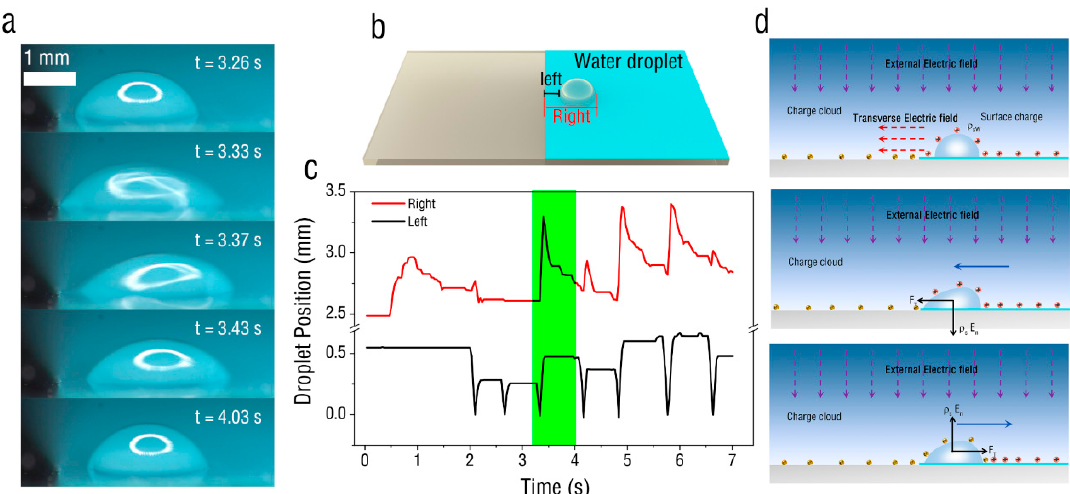
Figure 2. Movement of the water droplet on PET film. ( a ) Behaviors of droplet motion driven by corona discharge with voltage of 8 kV. ( b ) Schematic diagram of the experimental case. ( c ) The change in position of the left and right ends of the droplet with time. ( d ) Electrical principle of droplet movement.